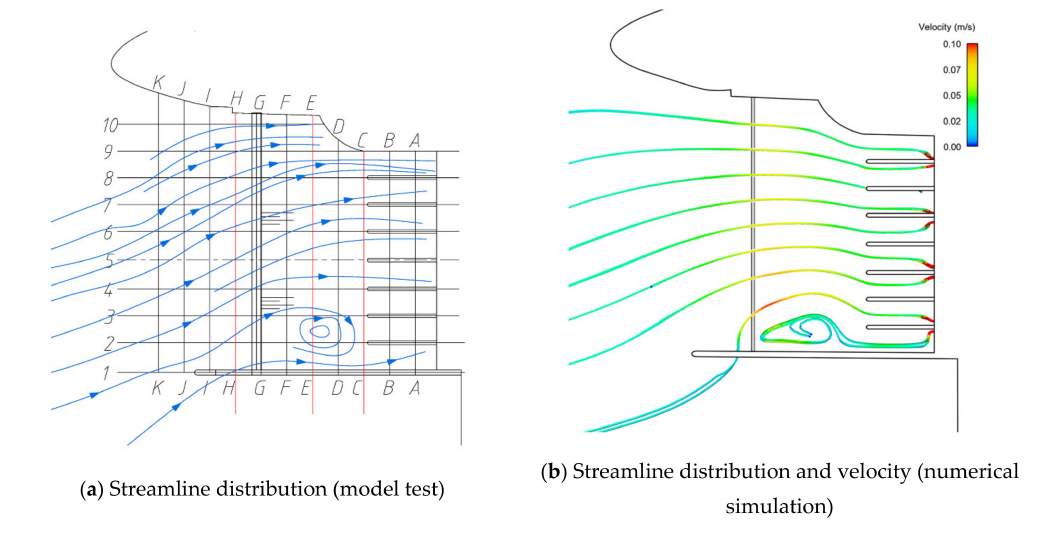
Figure 23. Plan 6 (design operating water level).